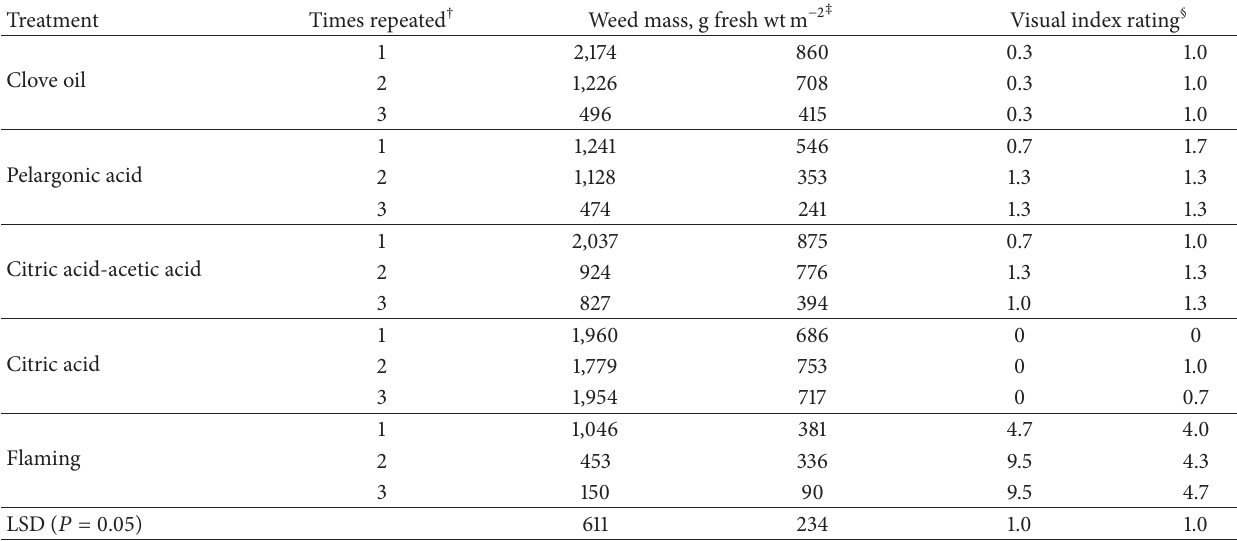
Table 8: End-of-season mass of shoots of weeds and ratings of efficacy of treatments with repeated applications of alternative practices in field plot research with annual and perennial vegetation (Field Experiment